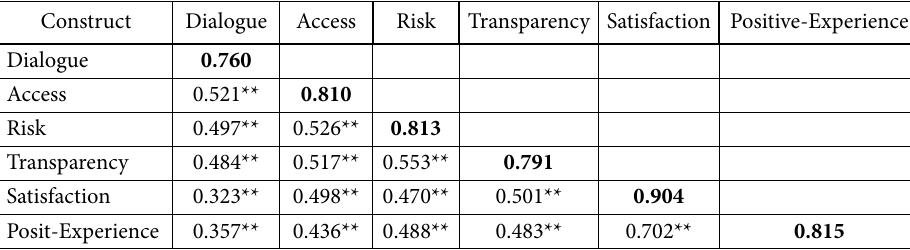
Table 3. SEM’s discriminant validity